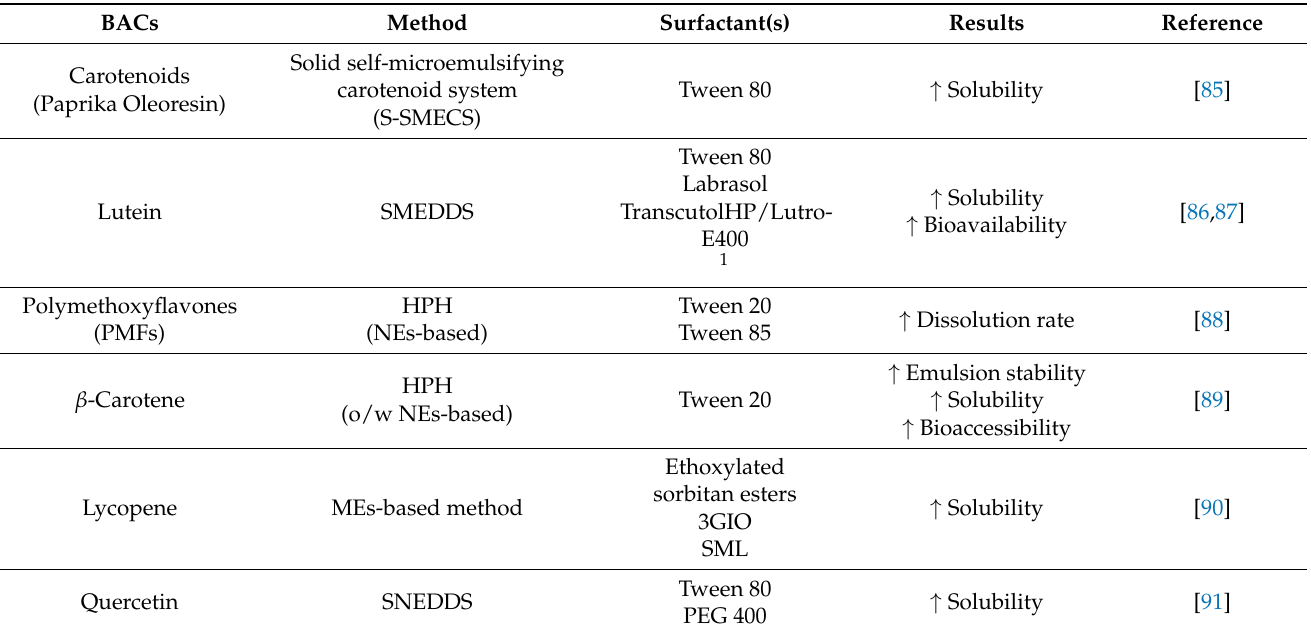
Table 6. Emulsion-based delivery systems for delivering